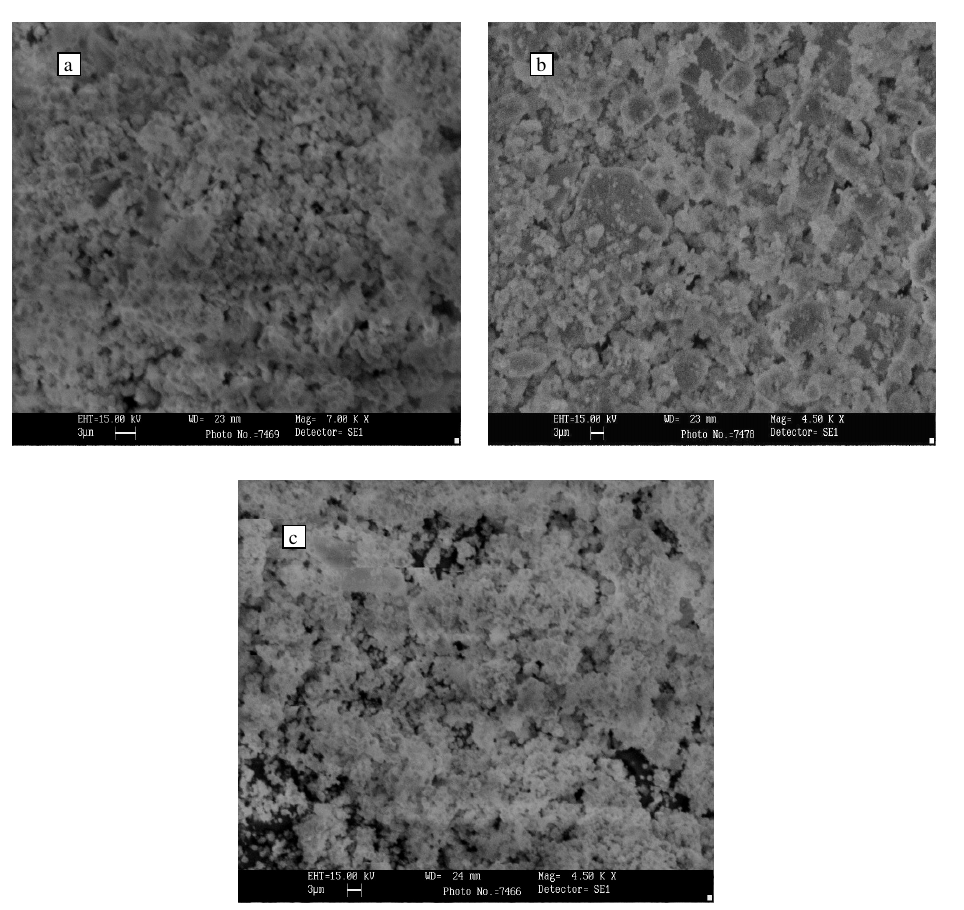
Figure 3. SEM image of (a) H- ZSM-5, (b) Na-ZSM-5 (c) PNa Effect of